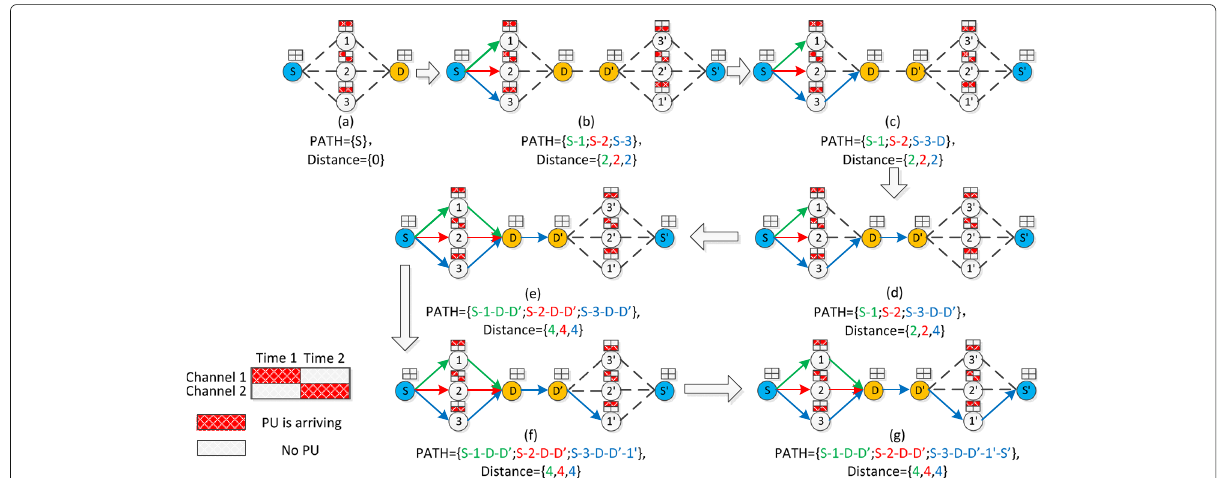
Fig. 5 The example of algorithm